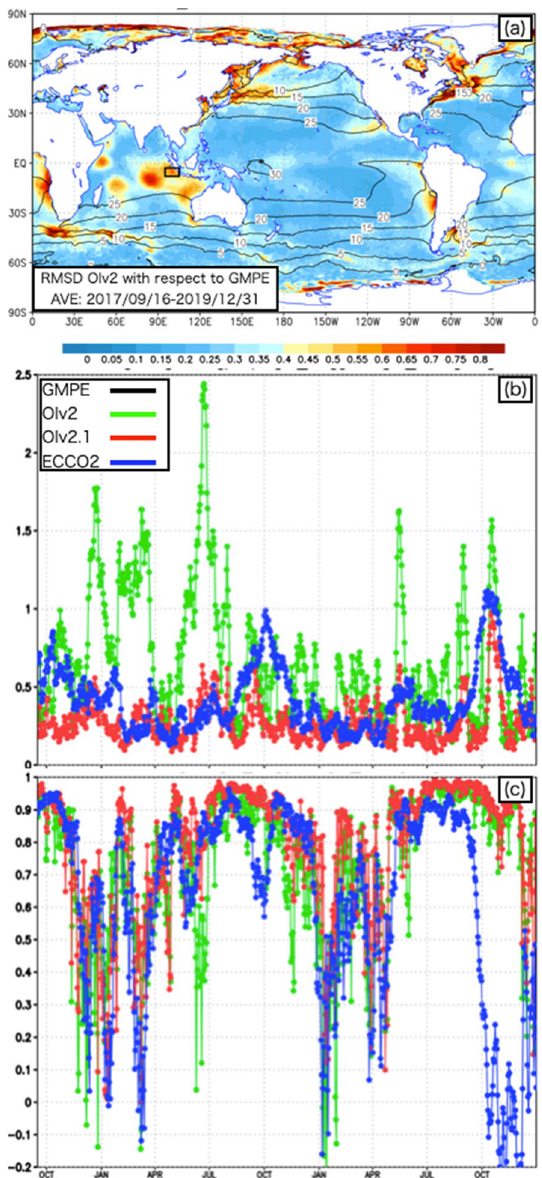
Figure 2. ( a ) RMSD of OIv2 with respect to GMPE (color) and SST with GMPE (contour) for the period from 1 Dec. 2017–31 Dec. 2019. Time series of area-averaged ( b ) RMSD and ( c ) the spatial correlation (SC) with respect to GMPE for the period from 16 Sep. 2017–31 Dec. 2019. OIv2, OIv2.1, and ECCO2 are shown in green, red, and blue, respectively. The averaged area is shown by the black box in